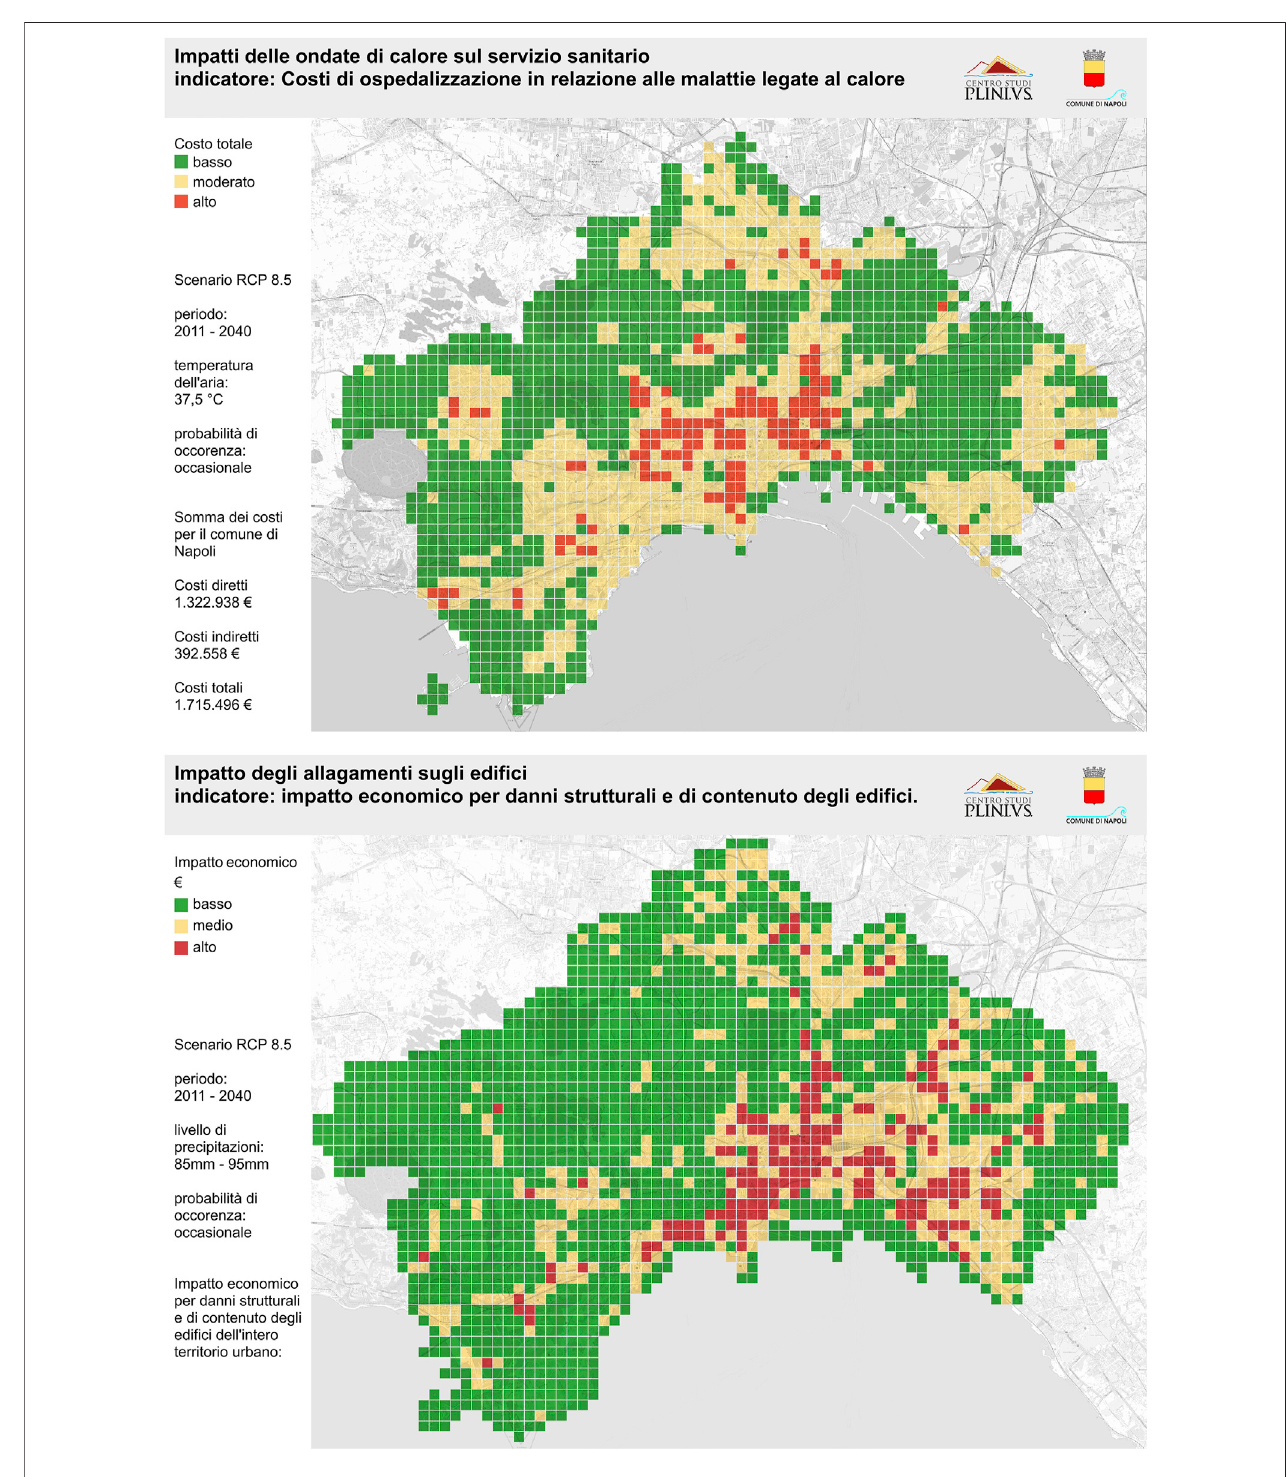
FIGURE 5 | Example of economic impact results from HWLEM, related to hospitalization costs due to heat-related diseases (top) , and FLEM, related to structural and content damage to buildings (bottom) , corresponding to an “ occasional ” event in the period 2011 – 2040, RCP 8.5.